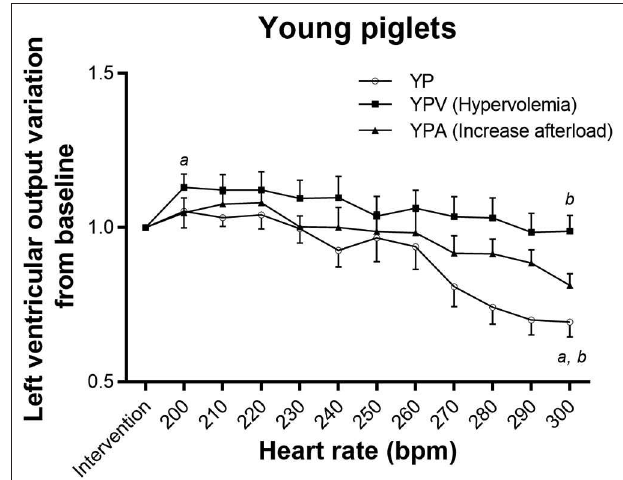
FIGURE 2 | Tolerance to tachycardia in young infant groups. Impact of atrial pacing on left ventricular output in the three groups. Both YP and YPA (increase afterload) had a decreased output with pacing (adjusted repeated measure ANOVA p -value < 0.001 and 0.001, respectively). However, the paired comparison between the left ventricular output after intervention and at 300 bpm became non-significant in the YPA group after adjustment for multiple comparisons ( p -value increased from 0.04 to 0.09) due to small numbers. Left ventricular output increased in YPV (hypervolemia) before going back initial values. a Different from post-intervention value ( p < 0.05). b Different from maximum value reached ( p <